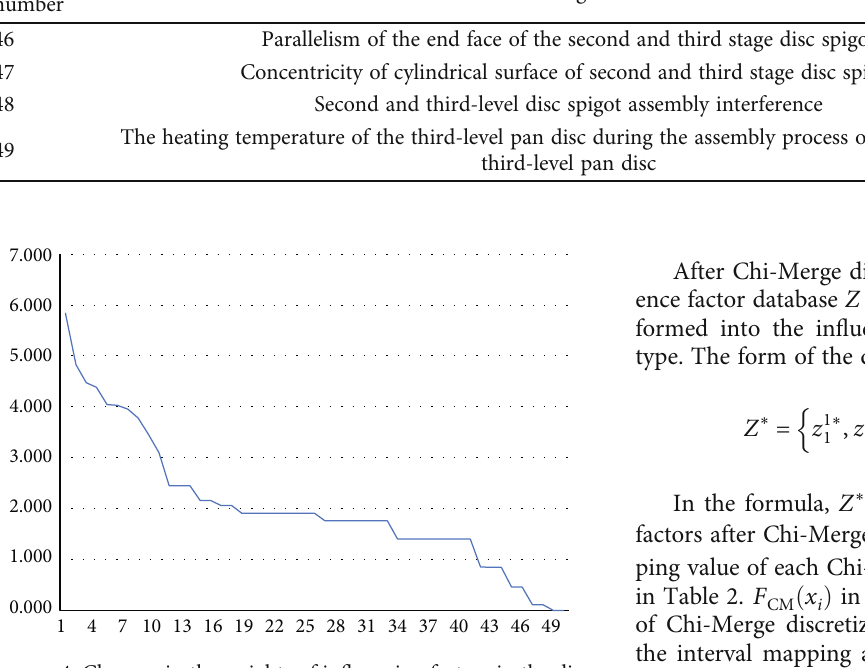
Figure 4: Changes in the weights of in fl uencing factors in the disc assembly